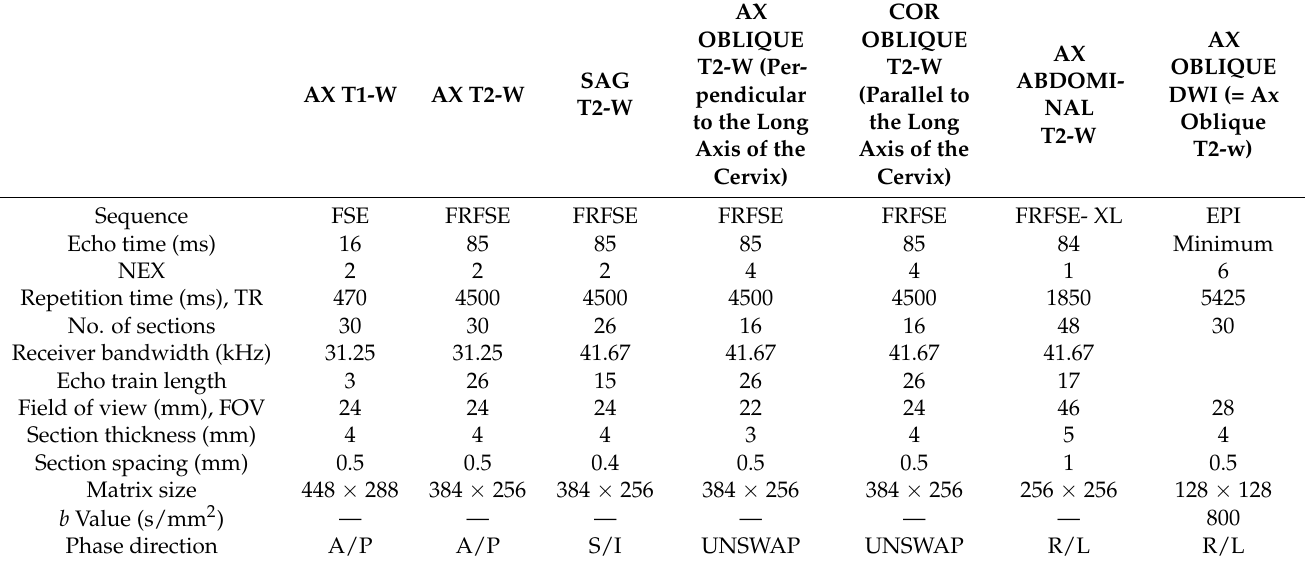
Table 2. Magnetic resonance imaging (MRI) acquisition parameters used in the MR clinical protocol adopted for axial (AX), sagittal (SAG) and coronal (COR)